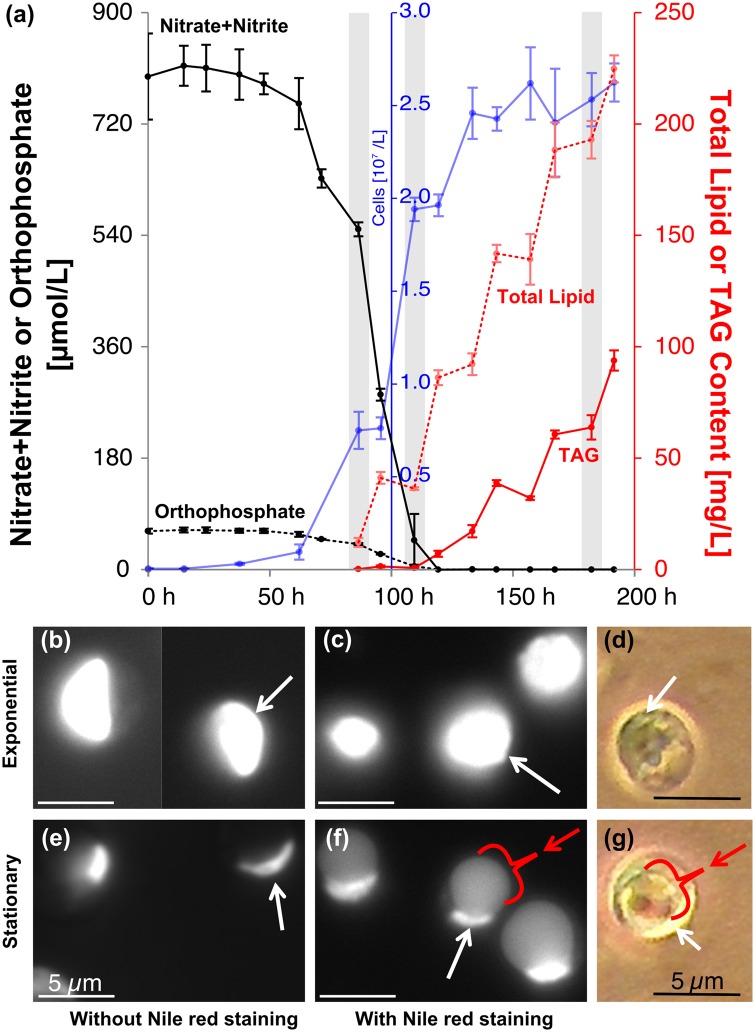
Lipid accumulation in Chlorella strain C596.(a) Time-course of a batch experiment culminating in N and P co-limitation (N:P = 13:1): nitrate+nitrite (black, solid), phosphate (black, dashed), cells (blue), TAG (red, solid), and total lipids (red, dashed) concentrations; error bars represent the 95% confidence interval. (b-g) Fluorescence and phase contrast microscopy of strain C596 cells grown in batch culture culminating in P limitation (N:P = 30:1). Samples were withdrawn during the exponential phase (b-d) and four days after onset of stationary (e-g) growth phase. The fluorescence microscopy reveals the chloroplast (autoflourescence, bright white) and Nile red stained lipids (in c and f; grey). The red arrows and brackets indicate intercellular TAG locations. The white arrows highlight the chloroplast.